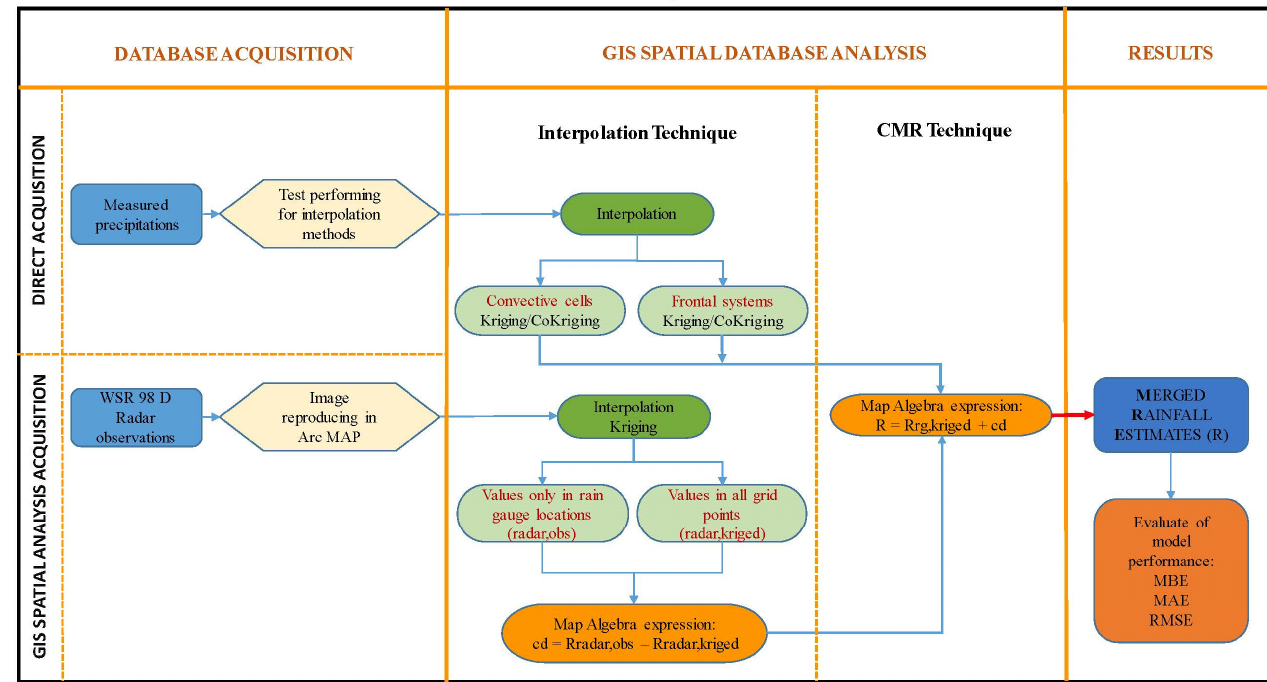
Figure 2. The scheme of the methodological workflow.